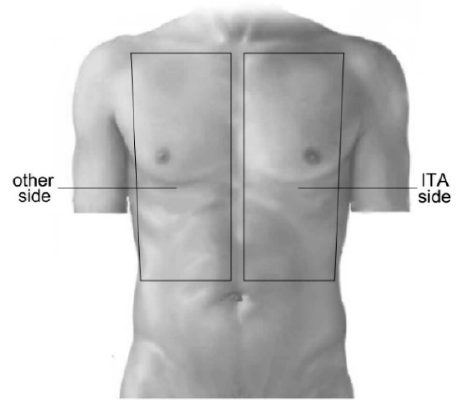
Figure 2. Recording area and regions of interest.